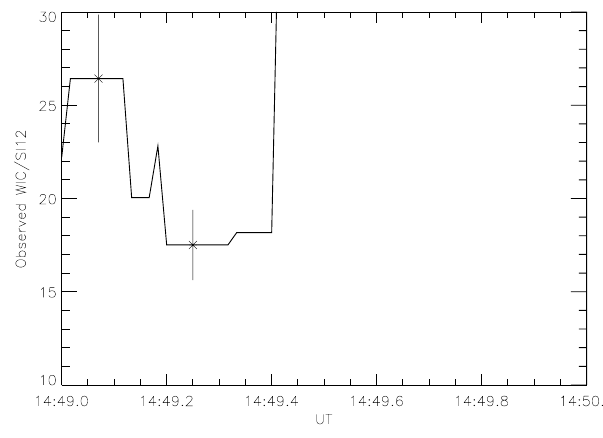
Fig. 7. Ratio of the WIC to SI12 signals for the proton arc observed on 26 November 2000 with